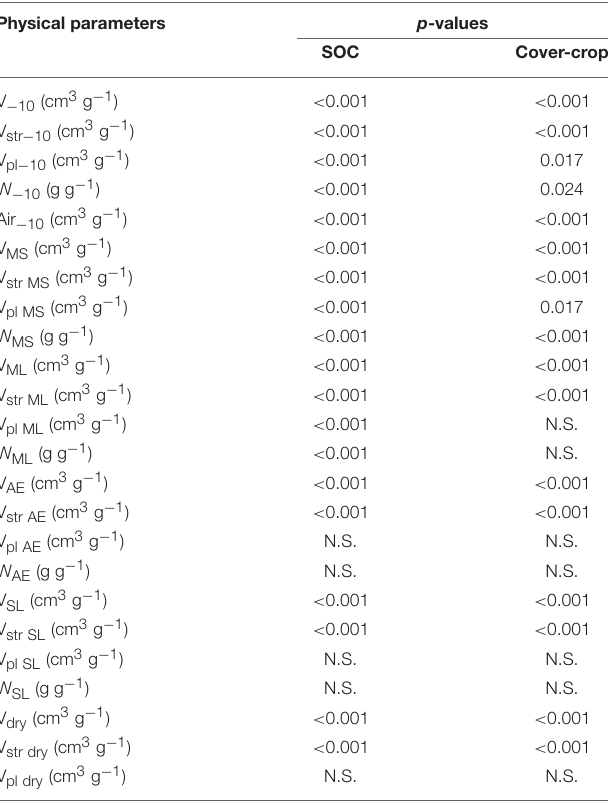
TABLE 3 | Results of the Ancova: significance of the effects of SOC and cover-crop treatment on the main physical parameters. Physical parameters p -values SOC